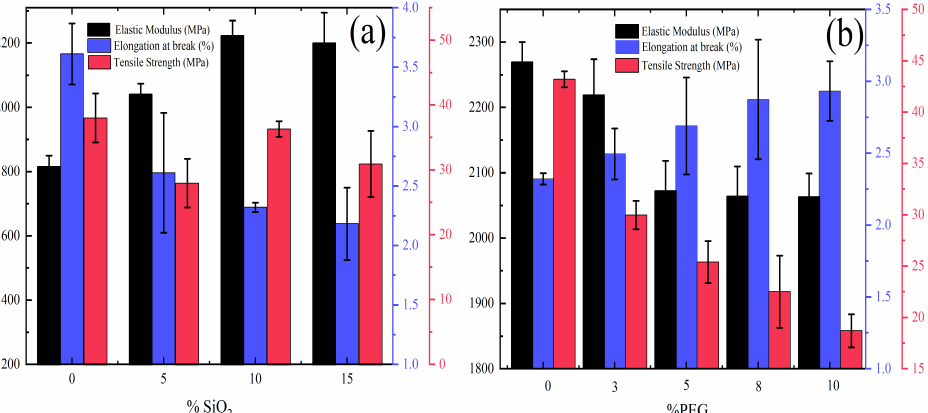
Figure 10. Mechanical properties (elastic modulus, tensile strength, and elongation at break) of: ( a ) PLLA/SiO 2 and ( b ) PLLA/SiO 2 /PEG